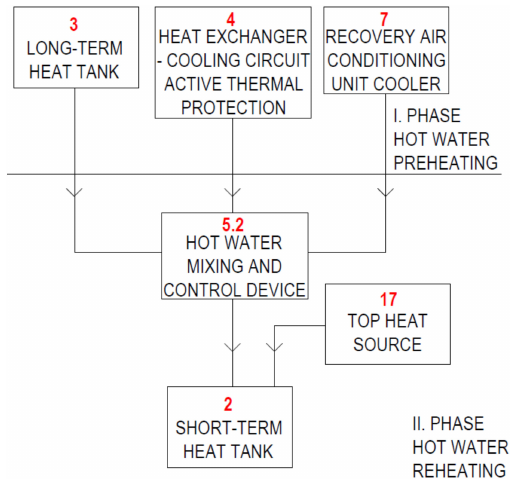
Figure 12. Functional diagram of the combined building-energy system in preheating and hot water reheating mode